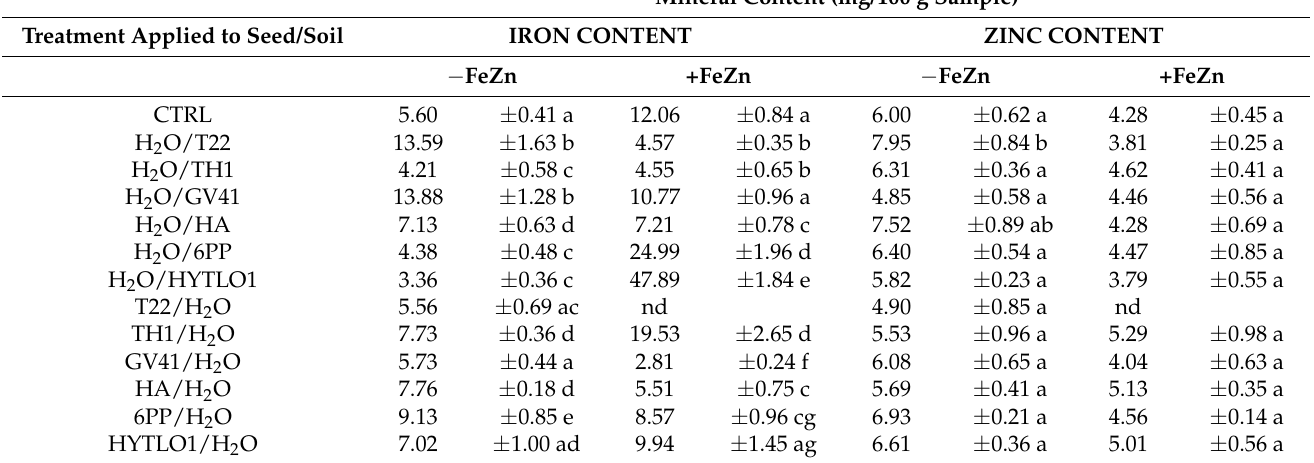
Table 5. Effects of Trichoderma strains (T22, TH1, GV41) or metabolites (HA, 6PP, HYTLO1), applied singly, on the lentil mineral content. Water treatments served as controls (CTRL). Treatments were ap- plied to the seed (indicated on the left), then to the soil (indicated on the right). After 7 d from the soil treatment, another soil watering was carried out using the 1X FeZn solution (+FeZn) or water ( − FeZn). Data represent the mean value of three biological replicates ± standard deviation (SD). Different letters in a column indicate statistically significant differences for p < 0.05; nd: Not